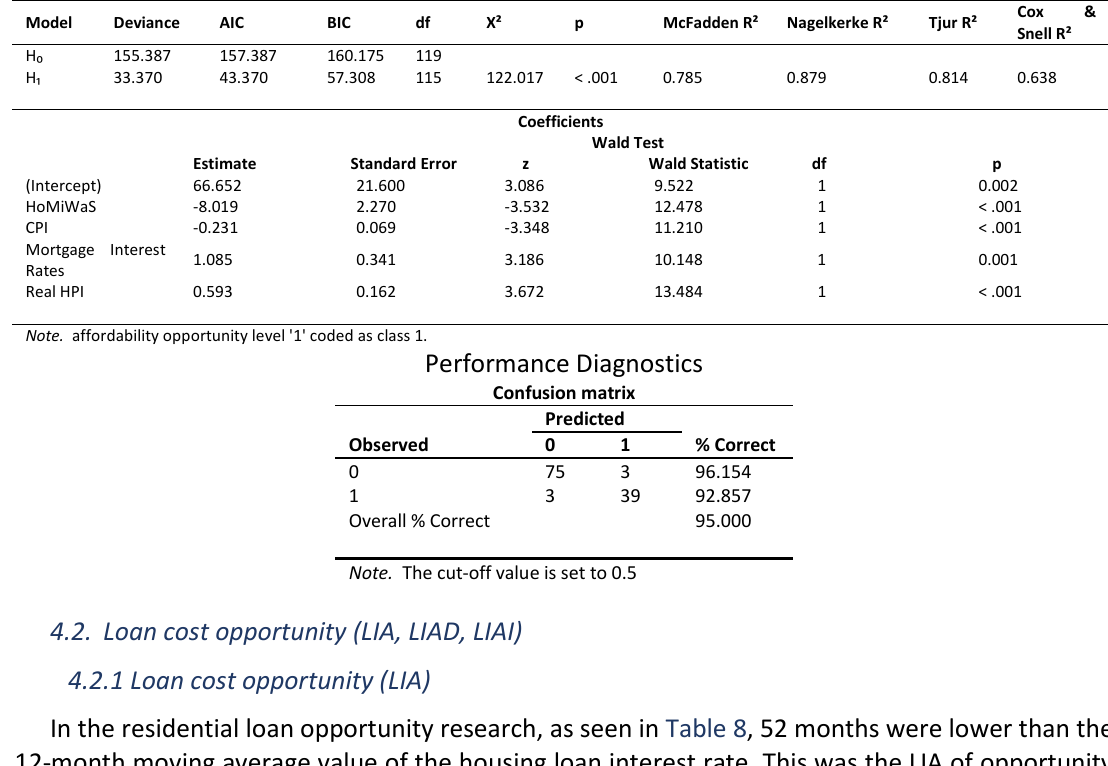
Table 7 HoMiWaSOpp Logistic